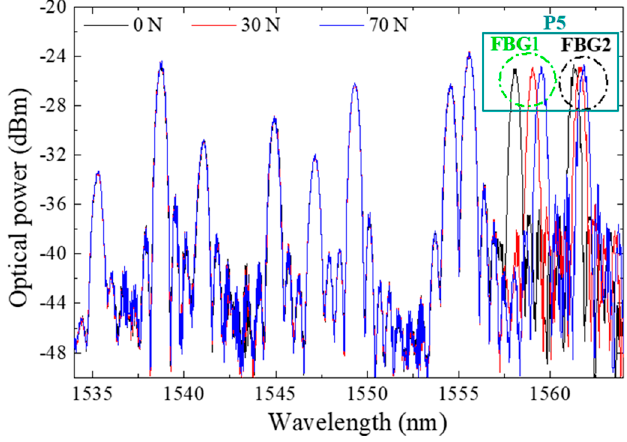
Figure 9. Optical spectra obtained during the pressure calibration of FBGs cell “P5”.